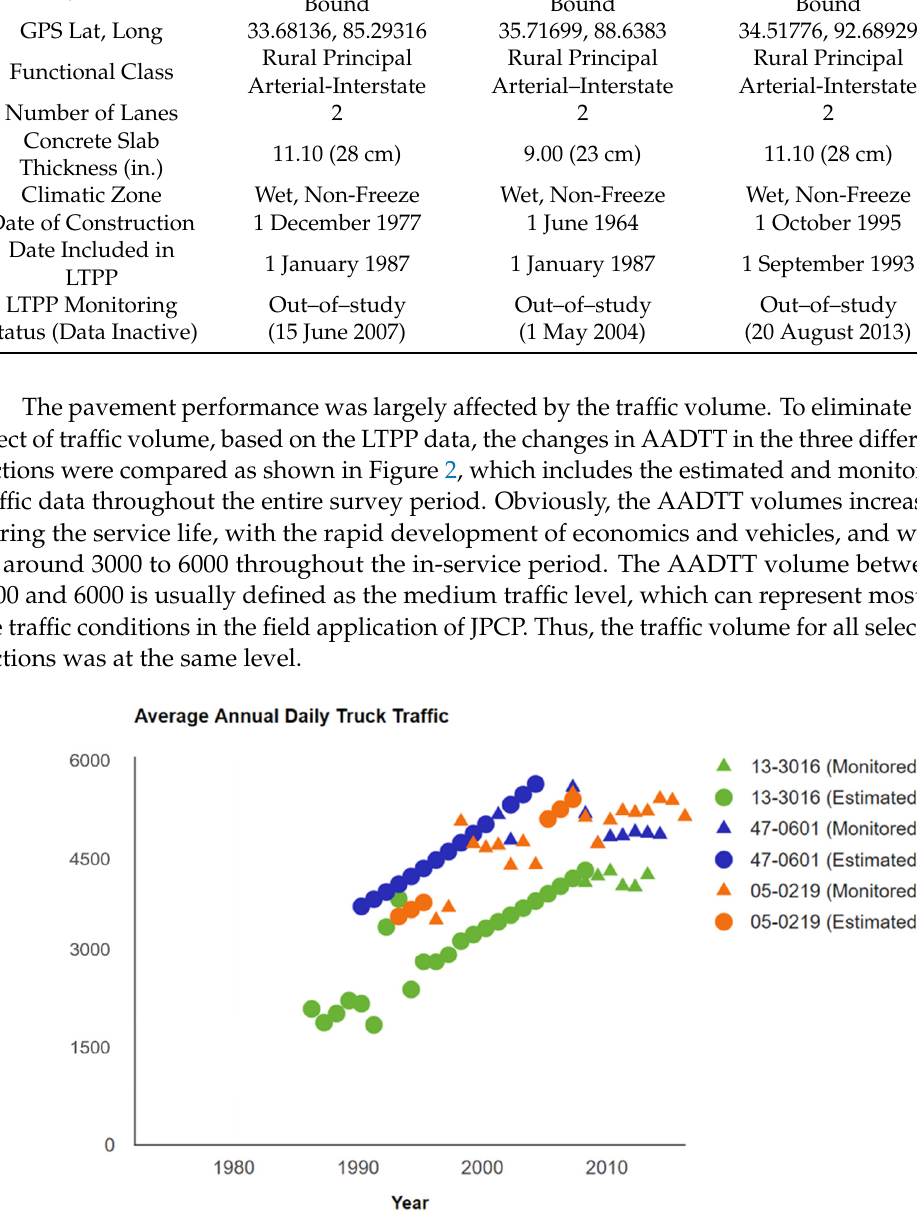
Figure 2. The change in average annual daily truck traffic (AADTT) in different sections. The average annual precipitation at the three different locations was also compared as illustrated in Figure 3. It can be observed that the average annual precipitation in these three sections was mostly in the range of 1000 to 1600 mm during the survey periods. The maximum average annual precipitation of about 2100 mm was found in the 05-0219 section in the year 2010, while the lowest average annual precipitation of about 800 mm was found in the 13-3016 section in the year 2008. Overall, the precipitation conditions in these selected sections were kept consistent at a certain level, therefore the precipitation effect could be dismissed.